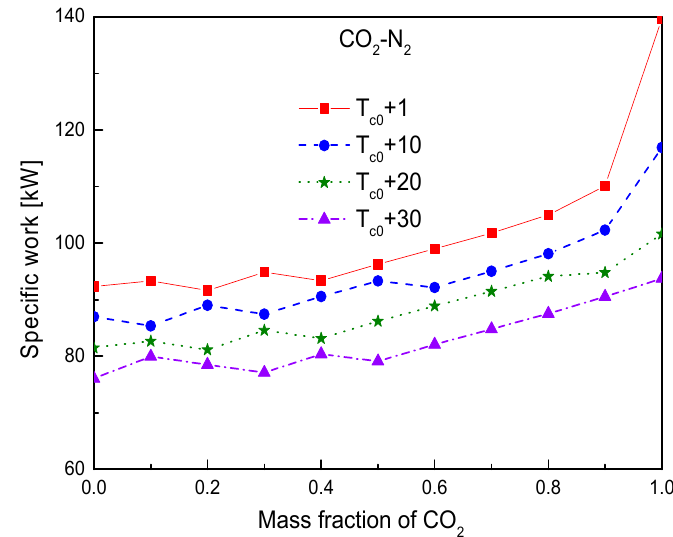
Figure 20. Specific work of CO 2 -N 2 at different compressor inlet temperatures.